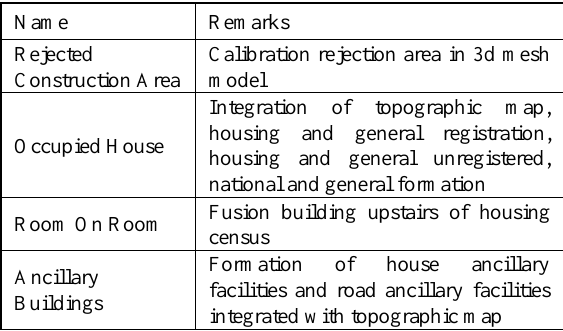
Table 1. Composition of housing thematic data in the one status map (core